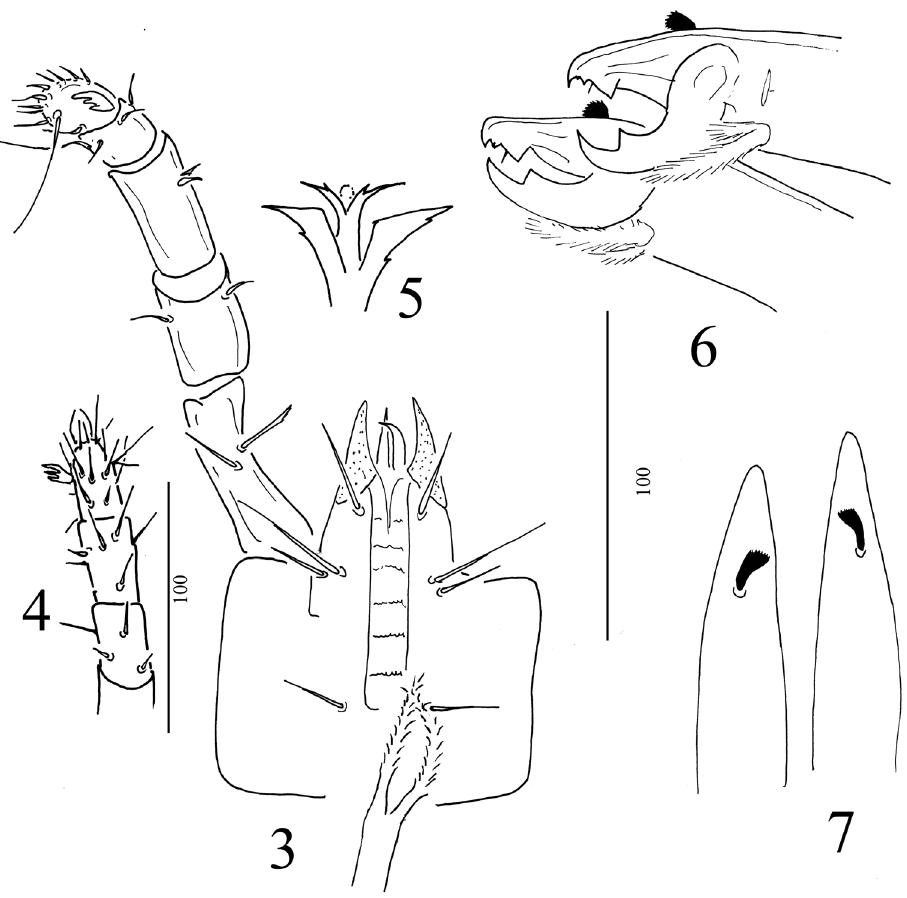
Figures 3–7. Macrocheles kekensis sp. n., female. 3 Ventral view of gnathosoma and palp 4 Palp in dorsal view 5 Tectum 6 Dorsal view of chelicerae 7 Lateral view of chelicerae.